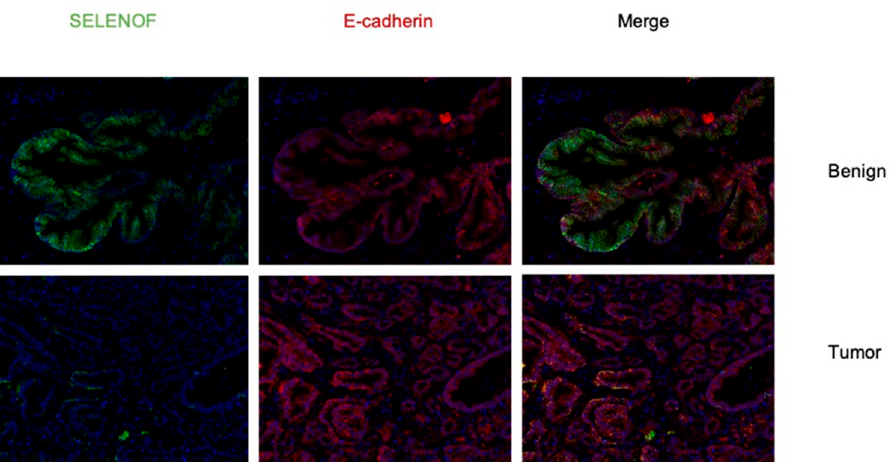
Figure 1. SELENOF levels are lower in prostate cancer compared to benign prostatic tissue. A representative immunofluorescent image of SELENOF (green) and E-cadherin (red). The top images show a region of benign prostatic tissue and the bottom images represent a region of prostate cancer. (Magnification = 20 × ). Staining with anti-E-cadherin antibodies was included both as a marker for the outer membrane and to restrict quantification of images to epithelial cells.